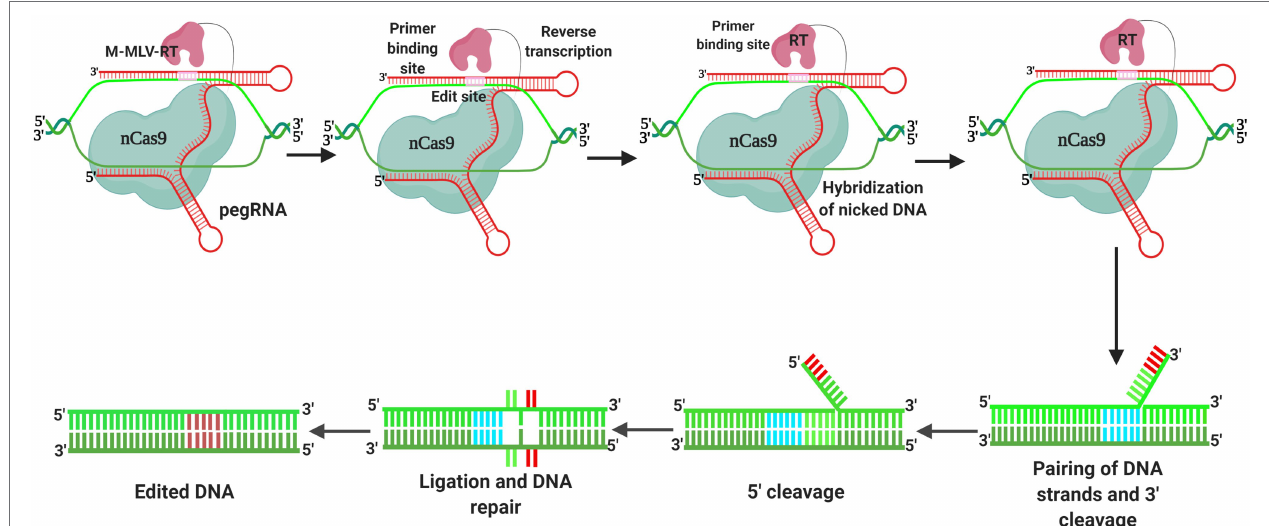
FIGURE 5 | Prime editing is a recently designed base editing technique that facilitates the accurate substitution, insertion, and deletion of sequences. The fusion of Nickase Cas9 (nCas9) and reverse transcriptase (RT) is the most important element in prime editing. The intended modifications are encoded by the prime editing gRNA, which directs the nCas9-RT complex to the target gene sequence. The DNA is cut by the prime editor, which is then hybridized to the primer-binding site, resulting in reverse transcription. DNA ligation and repair are followed by base pairing of 30 or 50 flaps, resulting in DNA